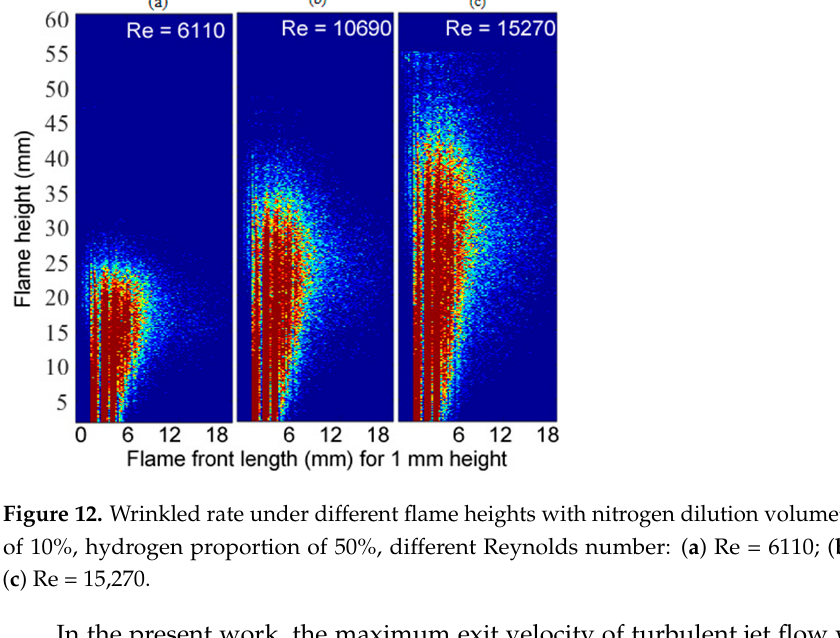
Figure 11. Wrinkled rate under different flame heights with nitrogen dilution volumetric proportion of 10%, Re = 10,690, different hydrogen proportion in fuel: ( a ) hydrogen volumetric rate of 5%; ( b ) 25%; ( c ) 50%; ( d ) 75%.